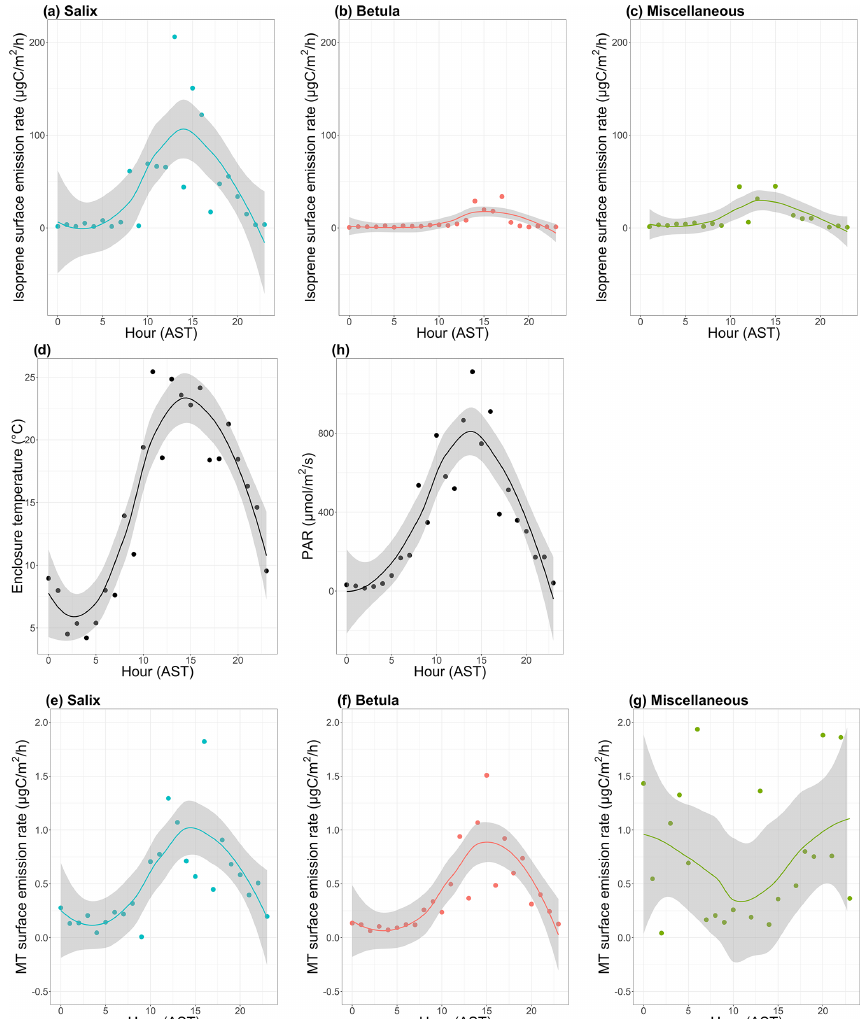
Figure 8. Mean diurnal cycle of isoprene (a–c) and monoterpenes (MT; e–g ) surface emission rates (in µgCm − 2 h − 1 ; note the differ- ence scale on the y axis), (d) enclosure temperature (in degrees Celsius), and (h) enclosure photosynthetically active radiation (PAR in µmolm − 2 s − 1 ). The dots represent the hourly means. The line is the smoothed conditional mean while the gray shaded region indicates the 95% confidence interval. Hours are in Alaska standard time (UTC − 9) and correspond to the end of the 2h sampling period for isoprene and MT emission rates. MT corresponds here to the sum of α -pinene, β -pinene, limonene, and 1,8-cineole. Miscellaneous refers to a mix of different species, including lichens and moss